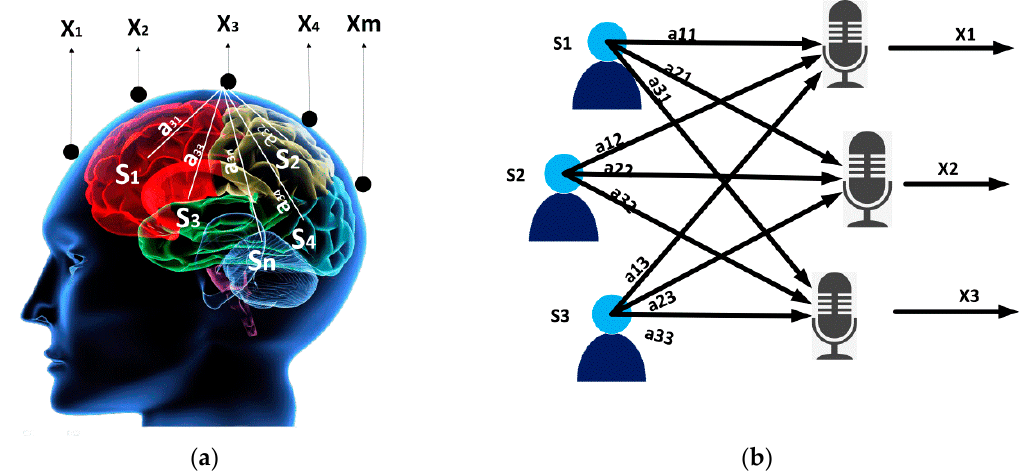
Figure 3. Similarity analysis of signal mixing process of electroencephalogram (EEG) and speech. ( a ) Signal mixing process of EEG; ( b ) Signal mixing process of speech .